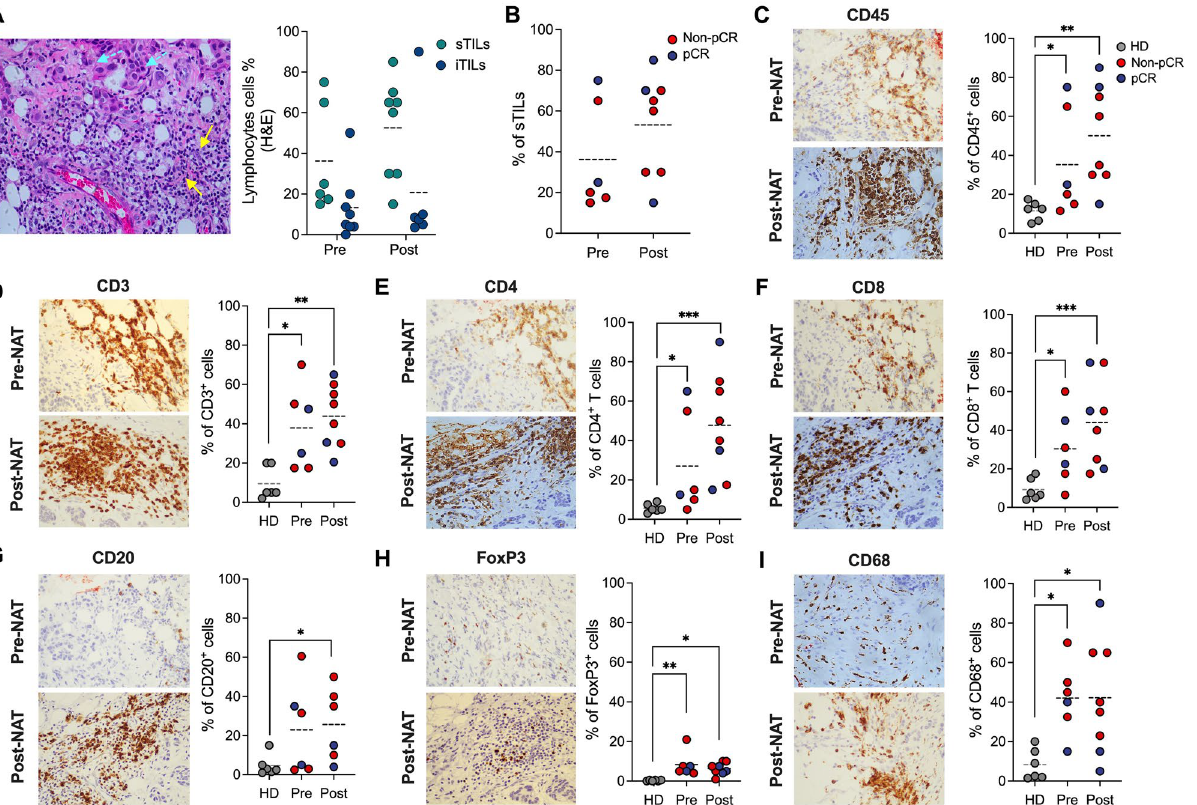
Figure 2. NAT changes the immune microenvironment in breast cancer patients. ( A ) Leukocyte infiltration of tumors from breast cancer patients by hematoxylin and eosin (H&E) staining of tissue sections pre- and post-NAT. Yellow arrows show stromal tumor-infiltrating lymphocytes (sTILs), and celeste arrows show tumor-infiltrating lymphocytes (iTILs). Images are at 40X magnification. ( B ) Frequency of sTILs in BCP with non-pCR or pCR pre- and post-NAT. ( C ) Representative IHC for CD45+ sTIL (left) staining in tumor samples pre- and post-NAT from the same individual and frequency of CD45 + cells (right), ( D ) CD3 + ( E ) CD4 + , ( F ) CD8 + , ( G ) CD20 + , ( H ) FoxP3 + , ( I ) CD68 + cells. In all cases, each point represents independent samples: gray circles correspond to HD, blue circles to pCR and red circles to non-pCR patients. Data are represented as the mean ± SEM. The p values were calculated using a Mann–Whitney test. * p < 0.05, ** p < 0.01, *** p <